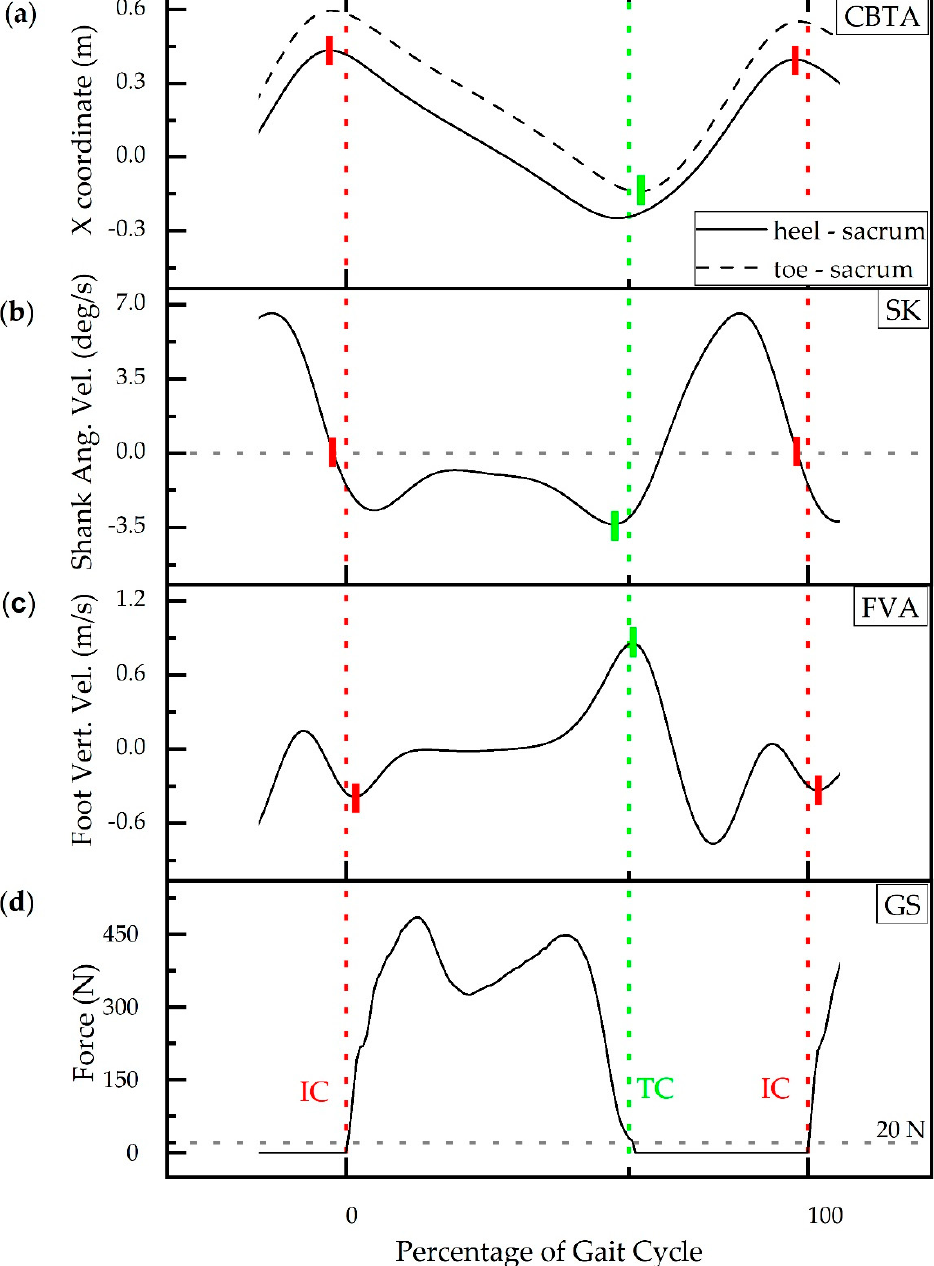
Figure 1. Representative kinematic and kinetic signals for four gait event detection methods (GEDM) during walking for a typically developing child. Kinematic GEDM: ( a ) the resultant X coordinate formed by the subtraction of the X coordinate of the sacral marker from the X coordinate of the heel marker (solid) and resultant X coordinate formed by the subtraction of the X coordinate of the sacral marker from the X coordinate of the toe marker (dashed) (CBTA); ( b ) shank angular velocity (SK); ( c ) vertical foot velocity (FVA); ( d ) ‘gold standard’ force plate method (GS). GS kinetic algorithm-based initial contact (IC) detection (red dotted line) and terminal contact (TC) detection (green dotted line). Solid red and green hash marks indicate IC and TC detection estimates by the respective kinematic methods.